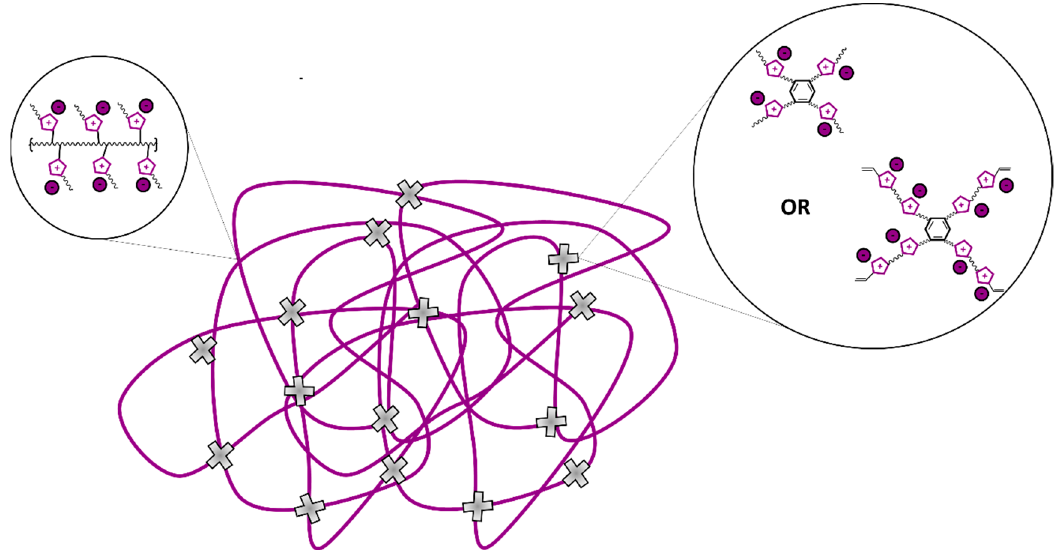
Figure 2. Visualization of poly(ILs) prepared from vinylimidazolium monomers polymerized with imidazolium-benzene based fillers or crosslinking agents in the membrane.